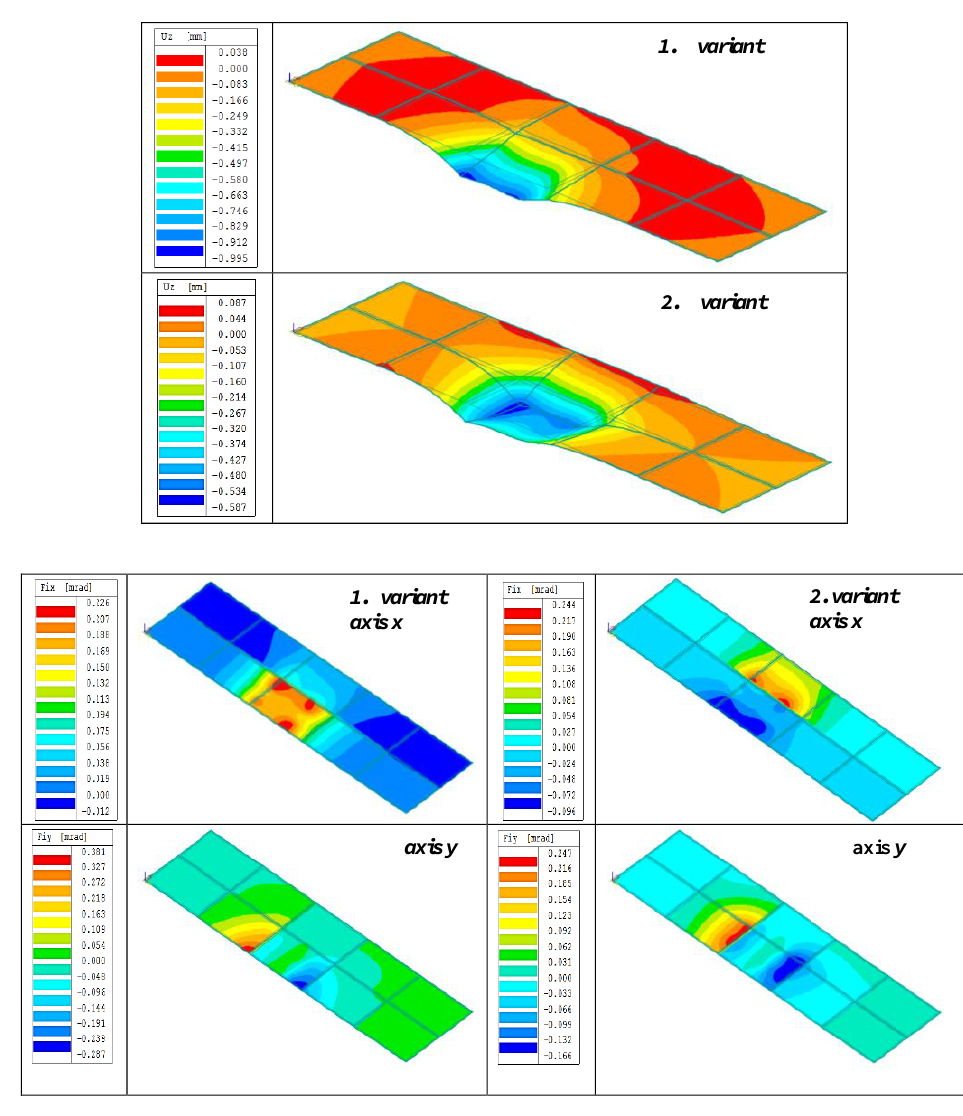
Figure 16. Numerical results — deformations.